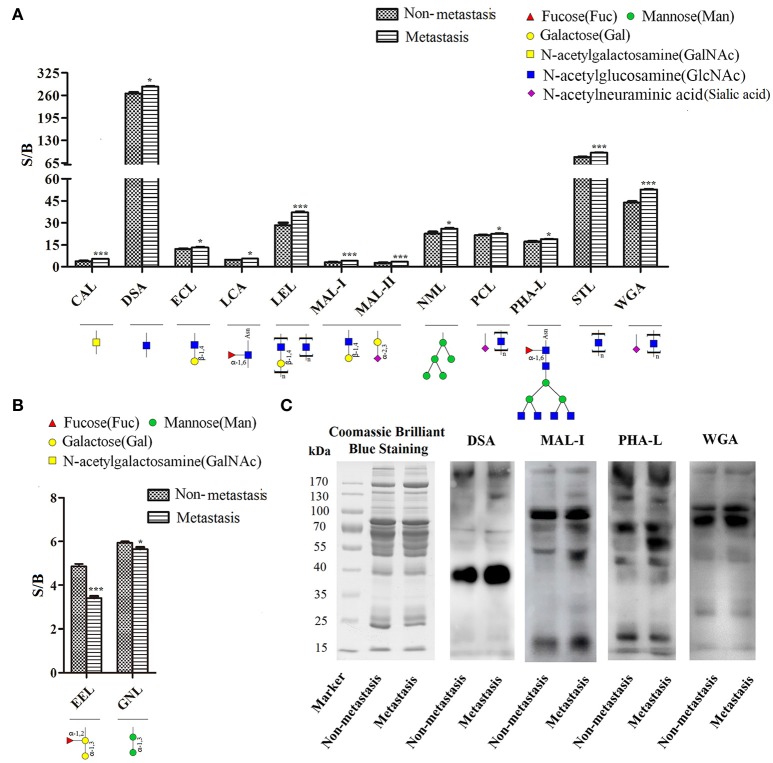
Screening and identification of changes in glycoforms of serum glycoproteins. (A) Specific binding abilities and quantitative results of lectins with significant up-regulated binding capacity in metastatic samples. (B) Specific binding abilities and quantitative results of lectins with significant down-regulated binding capacity in metastatic samples. *p < 0.05, ***p < 0.001. (C) Lectin blotting by biotinylated lectins: DSA, MAL-I, PHA-L, and WGA. Coomassie brilliant blue staining by PhastaGel™ Blue R showed similar global abundance of serum proteins in HCC patients with metastasis and those with non-metastasis. DSA, MAL-I, PHA-L, and WGA binding glycoforms were increased in HCC patients with metastasis compared with those with non-metastasis, which were consistent with the results of lectin microarray.